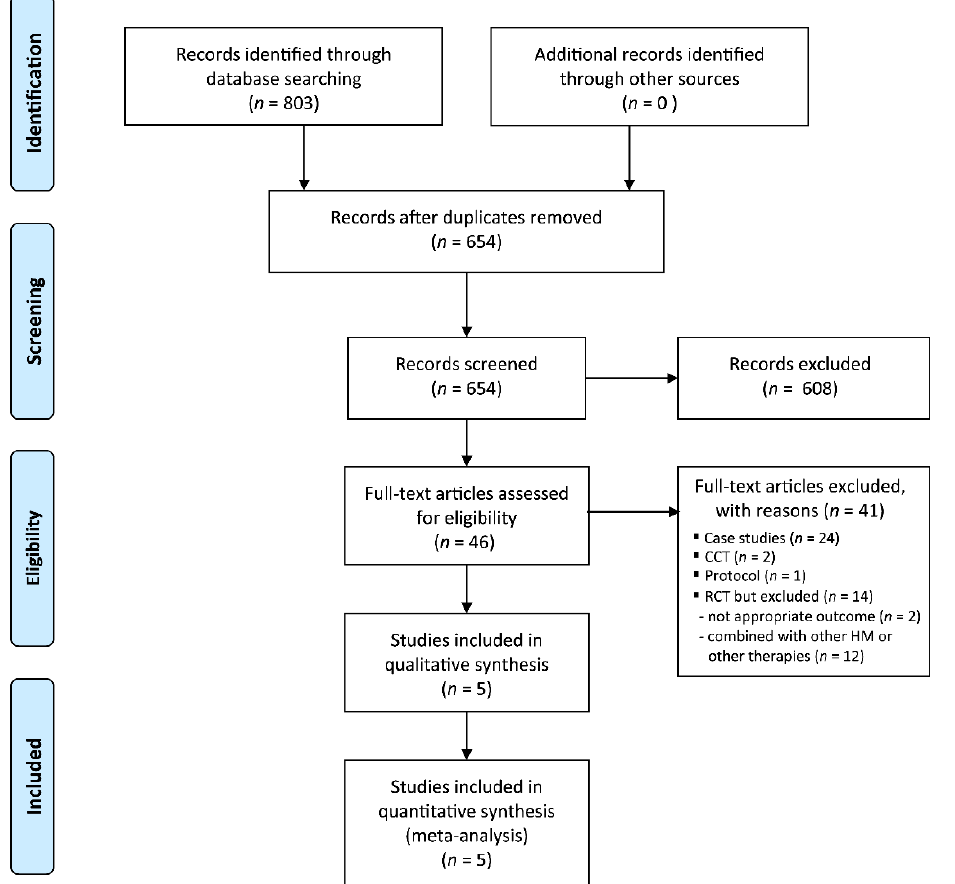
Figure 1. Flow chart of the trial selection process. CCT: clinical controlled trial; RCT: randomized controlled trial.